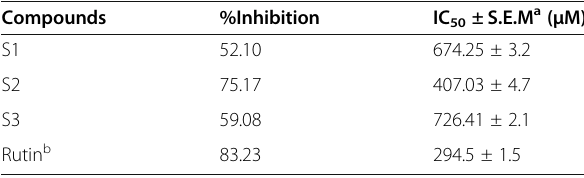
Table 1 In-vitro antiglycation potential of compounds isolated from I. heterantha ( N = 3)